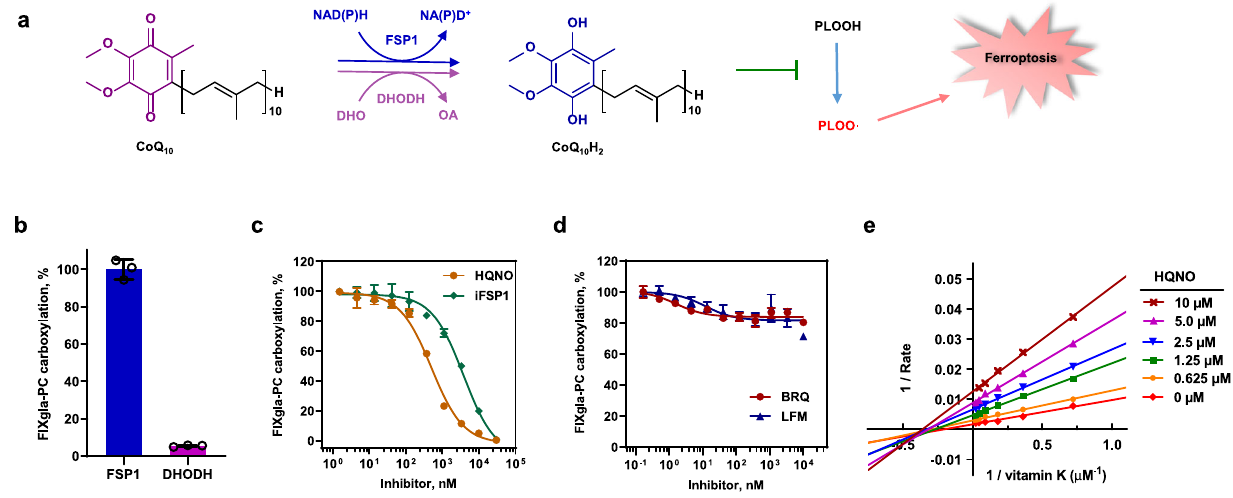
Fig.5|EffectoftheCoQ 10 -associatedferroptosissuppressionpathwaysonVKD carboxylation. a Scheme of the FSP1-CoQ 10 -NADH and DHODH-CoQ 10 -DHO pathways for ferroptosis suppression. CoQ 10 can be reduced to CoQ 10 H 2 by either FSP1 or DHODH using the reducing equivalent from NADH or DHO, respectively. Reduced CoQ 10 traps lipophilic radicals to suppress ferroptosis. NADH reduced nicotinamide adenine dinucleotide, NAD+ oxidized nicotinamide adenine dinu- cleotide, DHO dihydroorotate, OA orotic acid, PLOOH phospholipid hydroper- oxides, PLOO· phospholipid peroxyl radical. b Cell-based VKR activity of FSP1 and DHODH.FSP1andDHODHweretransientlyexpressedinTKOreportercellsfor24h for carboxylation activity assay. Wild-type FSP1 activity was normalized to 100%. c Effectof FSP1inhibitorsonVKDcarboxylation.Increasingconcentrationsof FSP1 inhibitors, HQNOor iFSP1, with 11 µ M vitamin K wereincubatedwith